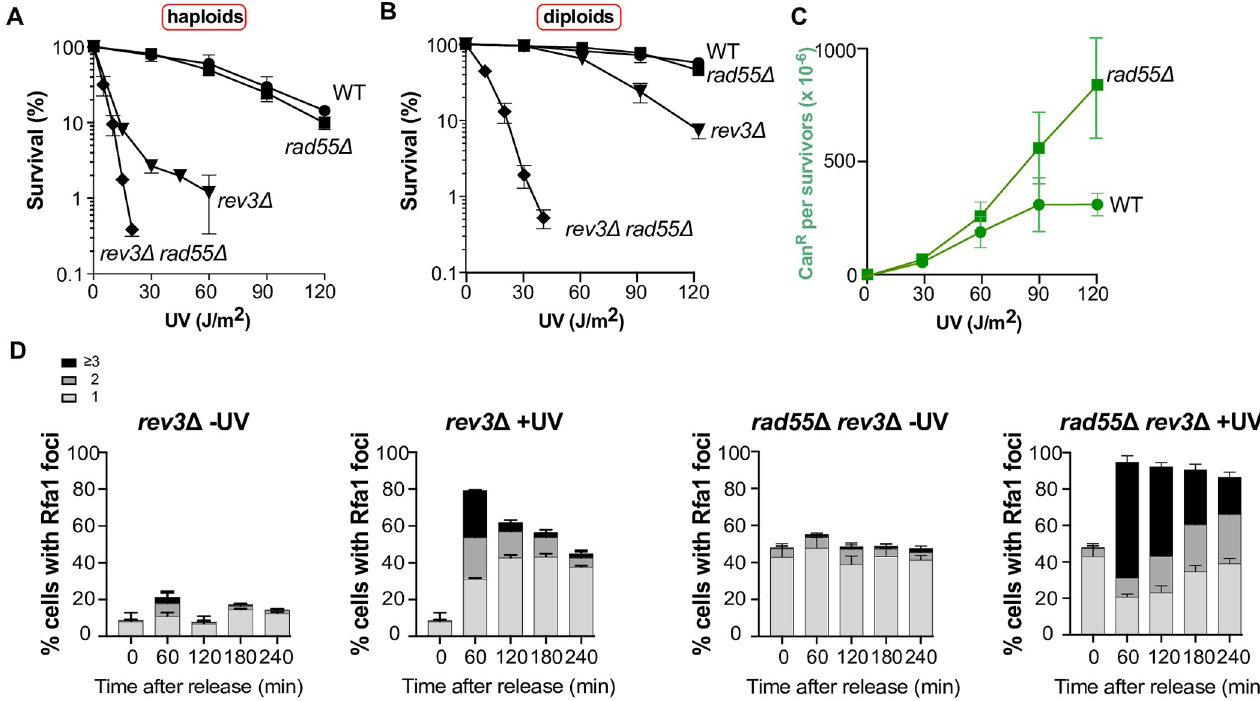
Fig 2. Channeling UV-induced DNA lesions into the REV3 -dependent pathway in rad55 Δ cells. (A) Survival of haploid cells following UV radiation. (B) Survival of diploid cells following UV radiation. (C) UV-induced mutagenesis in WT and rad55 Δ cells determined by quantifying the Can R mutant frequency for the indicated UV doses. (D) Quantification of Rfa1-YFP foci detected by fluorescence microscopy in rev3 Δ and rad55 Δ rev3 Δ cells not irradiated or after UV exposure. Error bars indicate SDs from three independent experiments.